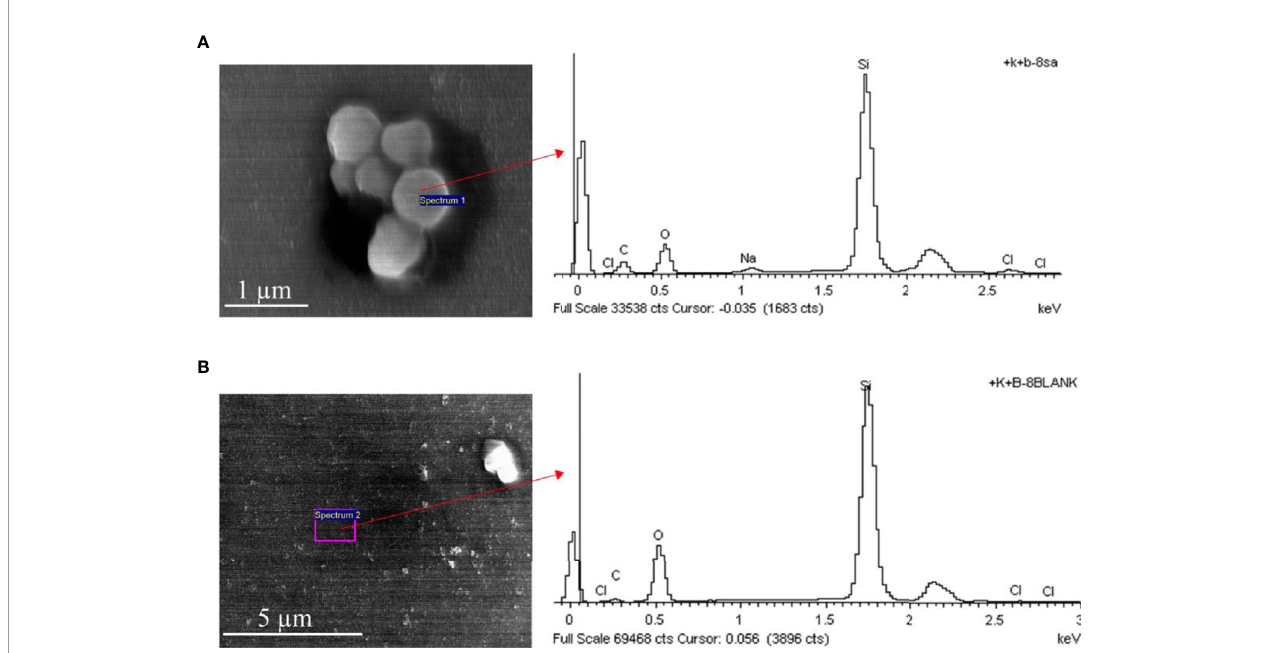
FIGURE 2 | The SEM and EDX images of S. aureus and blank area on the surface of the fi ber probe. (A) S. aureus captured on the fi ber probe on the surface of the fi ber probe. (B) The blank area of the fi ber probe without S. aureus . The composition of the silicon optical fi ber probe is mainly Silicon dioxide (SiO2), and the surface of the probe is rich in Si atoms and O atoms. While the S. aureus and other bacteria are organisms with carbohydrate as the main component, which is rich in Carbon (C) atoms and Sodium (Na) atoms. Therefore, the EDX image showed that the peak of the relative content (atomic percentage, Atomic %) of the C atoms and Na atoms were higher in the area where S. aureus were captured (A) than that in the blank area (B) . However, since the background of the SME imaging is the silicon optical fi ber probe, the percentages of Si atoms and O atoms are still dominant, regardless of the presence or absence of S. aureus and other bacteria. By this way, the presence or absence of S. aureus and other bacteria on the surface of the probe can be distinguished. SEM, scanning electron microscope; EDX, energy dispersive x-ray